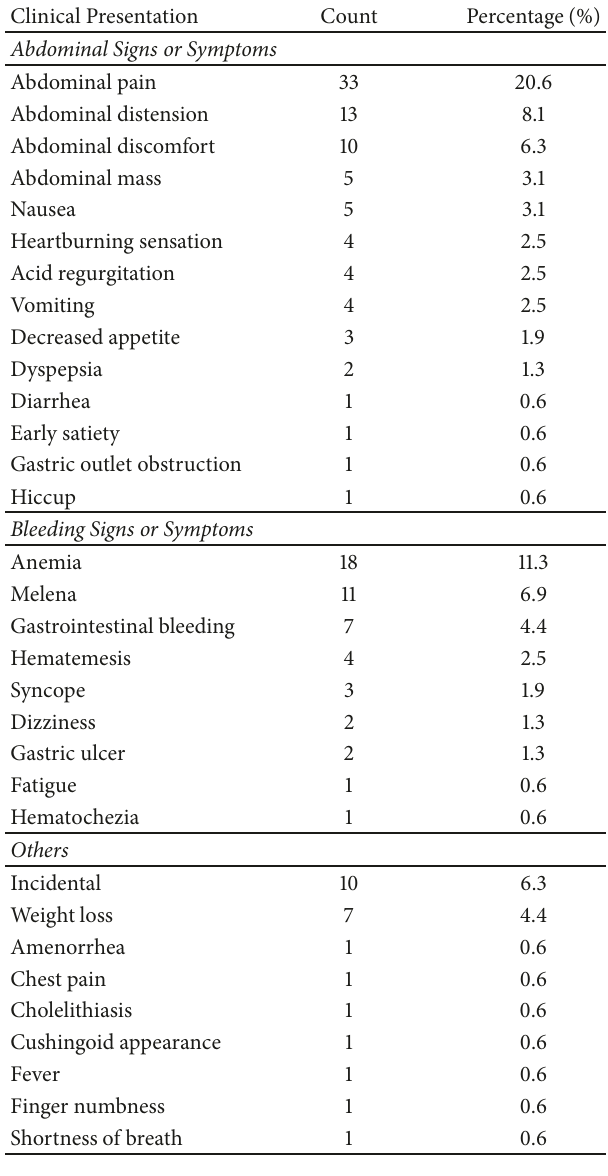
Table 2: Reported clinical presentations of PF in the